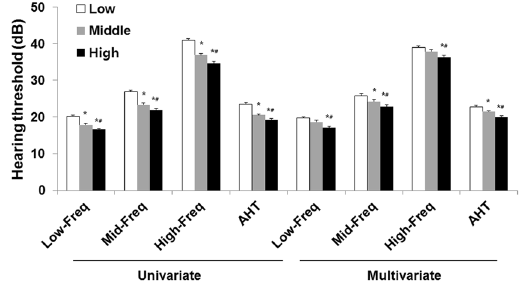
Figure 1. Hearing thresholds according to potassium intake tertiles. Multivariate analysis was adjusted for age, sex, diabetes mellitus, hypertension, household income, smoking habits, alcohol intake, education level, physical activity, eGFR, calorie intake, protein intake, fat intake, carbohydrate intake, sodium intake, occupational noise exposure, explosive noise exposure, vitamin A intake, carotene intake, retinol intake, thiamine intake, riboflavin intake, niacin intake, vitamin C intake, and serum vitamin D levels ( P < 0.001 for trends in all analyses). The data are expressed as mean and standard error values. * P < 0.05 versus the low tertile group. # P < 0.05 versus the middle tertile group. Abbreviations: AHT, average hearing threshold; Low-Freq, low frequency threshold; Mid-Freq, middle frequency threshold; High-Freq, high frequency threshold; eGFR, estimated glomerular filtration rate.